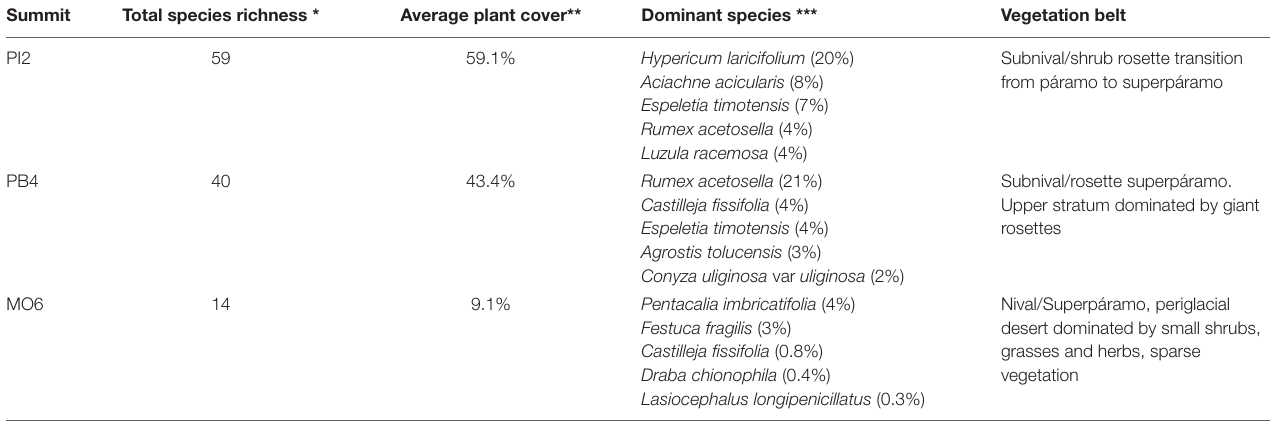
TABLE 1 | Characteristics of the selected summits for monitoring the flowering phenology and plant–pollinators networks within the framework of the GLORIA–Andes network in